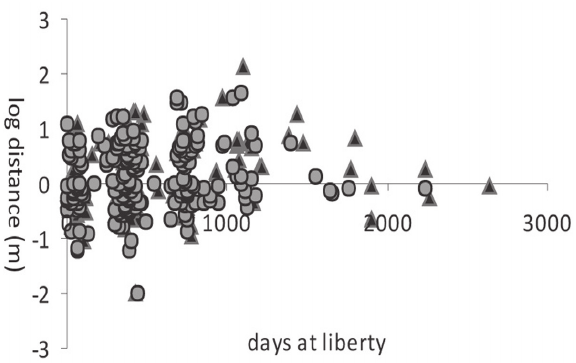
Fig . 3. – relationship between days at liberty and distance travelled by males (circles) and females (triangles).